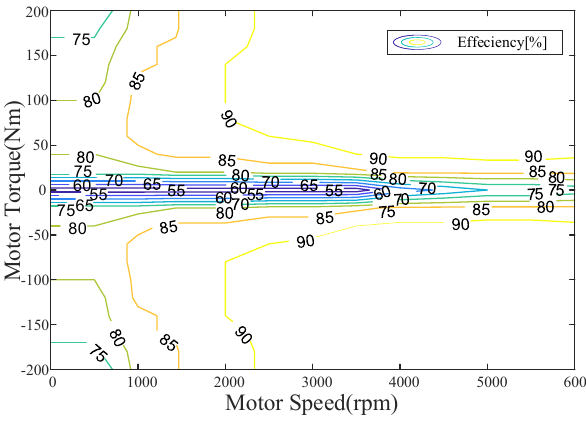
Figure 4. Efficiency map of the electric